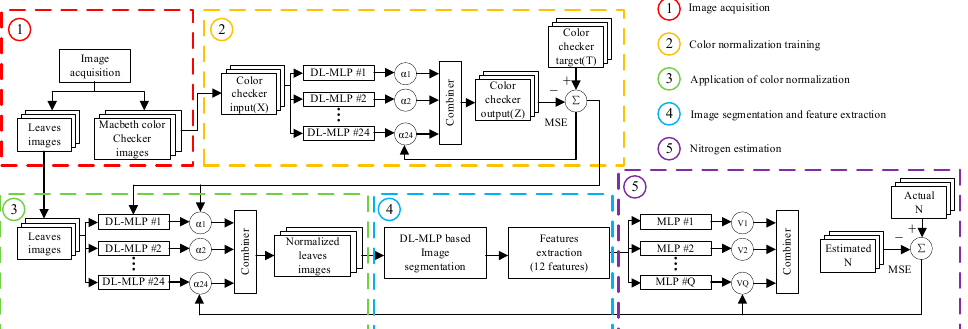
Figure 5. Method based on deep learning for on-field N status estimation in